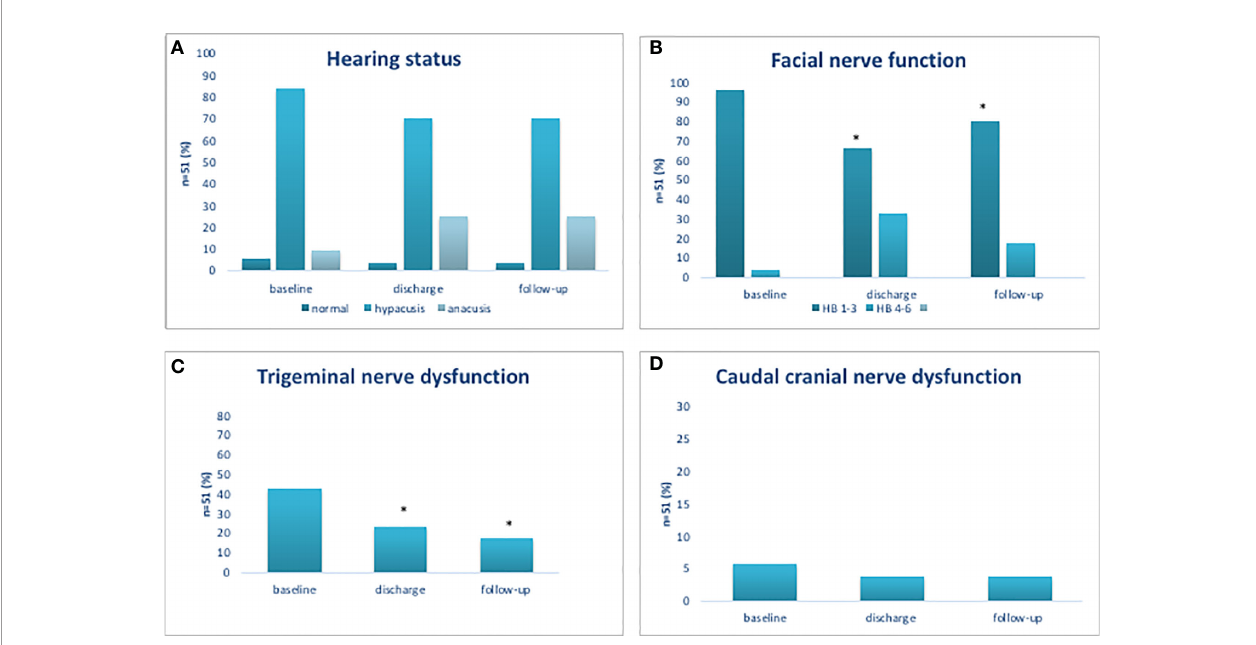
FIGURE 2 | Functional outcome of cochlear (A) , facial (B) , trigeminal (C) , and cranial caudal nerve (D) . Functional outcome of cochlear, facial, trigeminal, and cranial caudal nerve. *p <